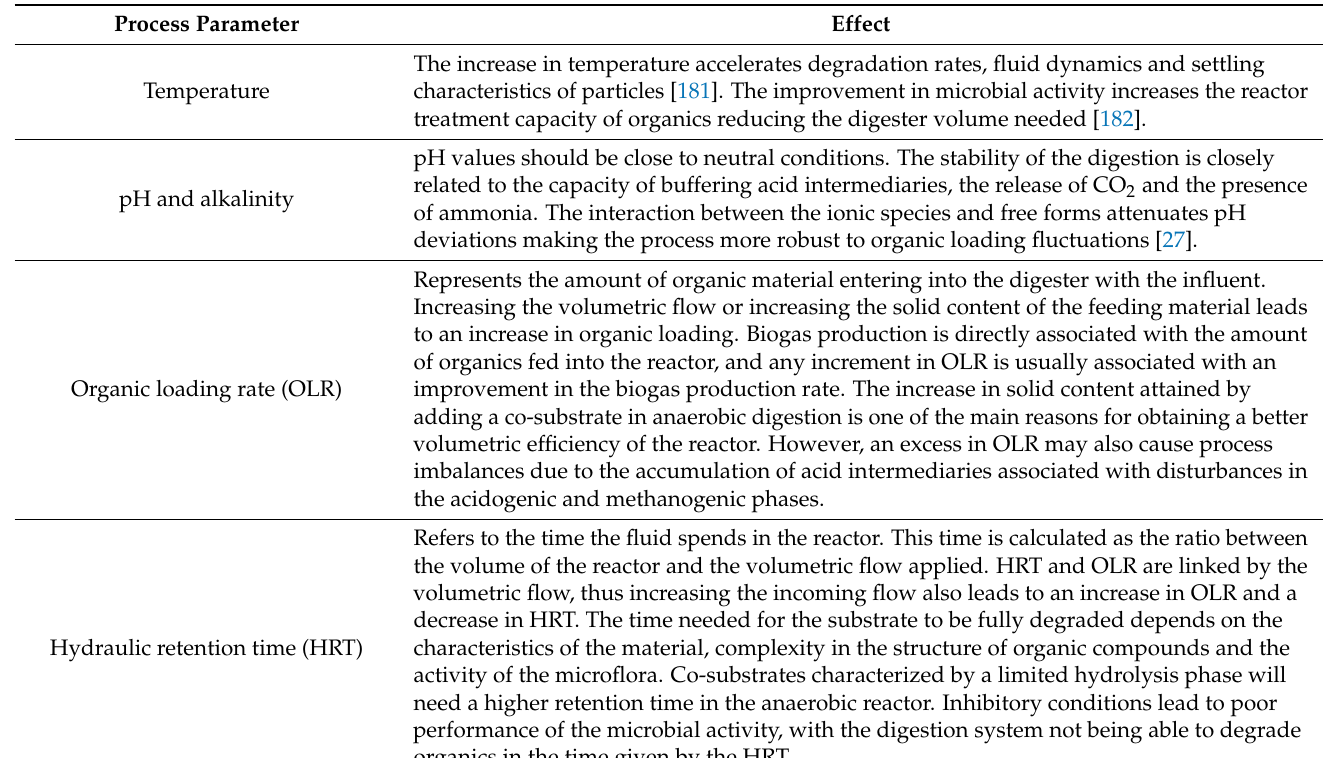
Table 6. Process parameter influencing anaerobic digestion